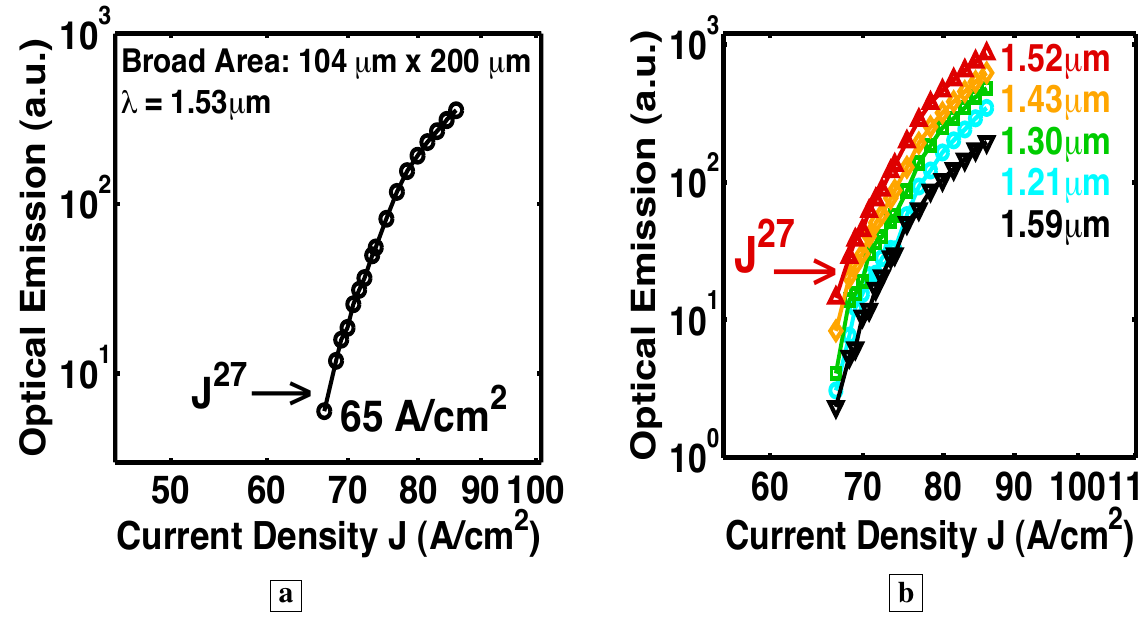
Figure 16 . Room-temperature L-I curves [5] measured in cw-mode from a resonant cavity with both a bottom DBR and RIE facets. a, With the optical-feedback resulting from RIE facets, the stimulated-emission from Sample K is seen to rise sharply as J s , where s is as large as 27. b, The constant vertical separation on a log-log plot of the L-I curves at different wavelengths from the same pixel indicates that the optical-emission has the same spectral shape for all indicated J, and that the carrier distribution is pinned among the energy-levels. (Without the resonant cavity, the optical emission shows a significant shift in the population distribution with increasing injection.)